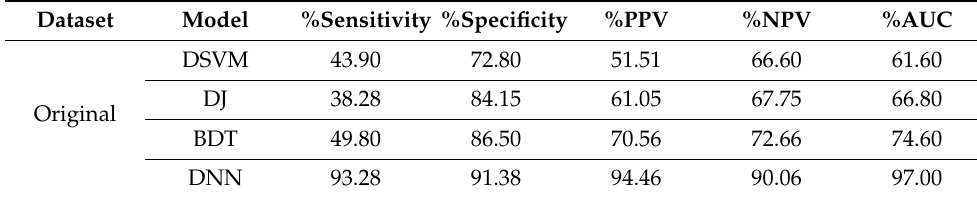
Figure 10. PCA analysis on the augmented dataset. Table 5. Performance of the ML algorithms’ tests on the augmented dataset.